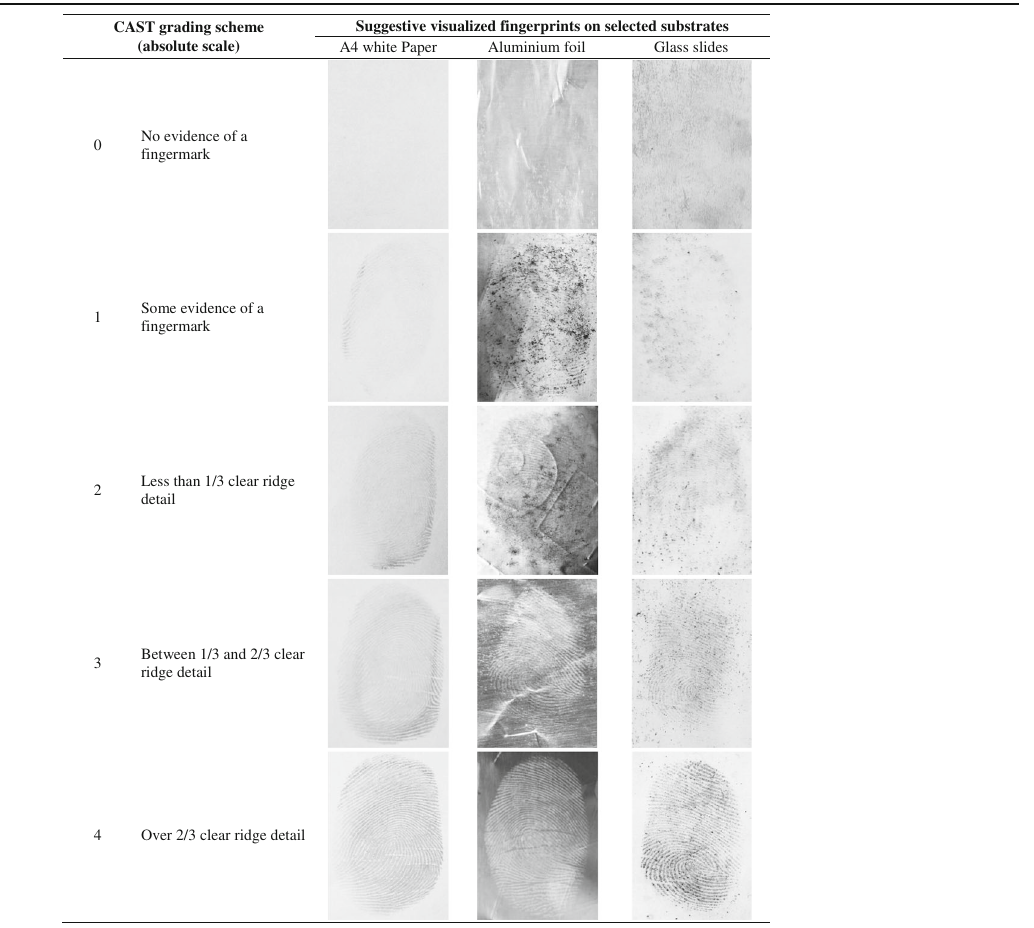
Table 2 Suggestive representative photographs of visualized fingerprints on selected substrates against the absolute scale reported by the Centre of Applied Science and Technology (International Fingerprint Research Group